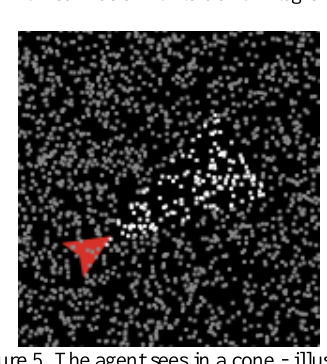
Figure 5. The agent sees in a cone - illustration (defined by opening angle and distance